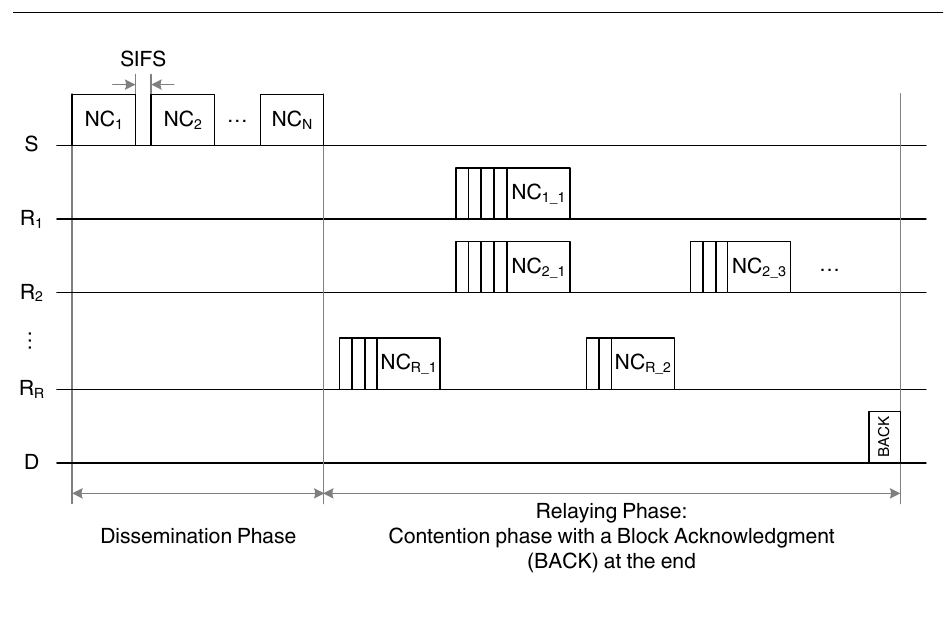
Figure 4. Example of the network coding (NC)-MAC transmission